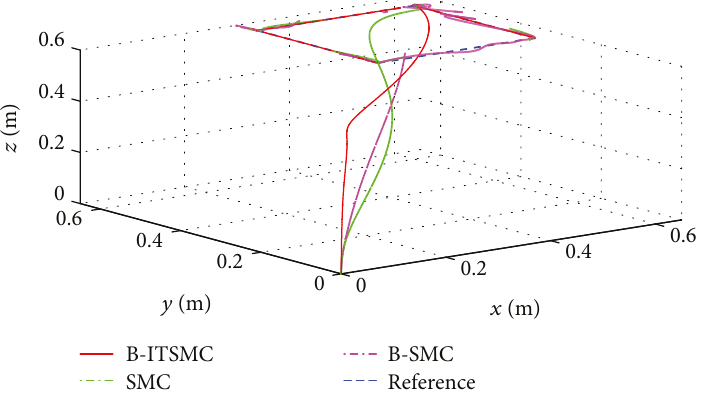
Figure 7: Flight trajectory tracking, B-RITSMC.